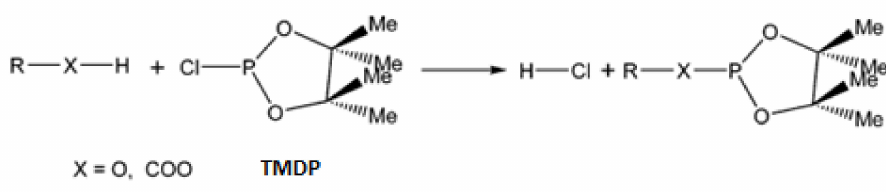
Figure 4. Derivatization process with